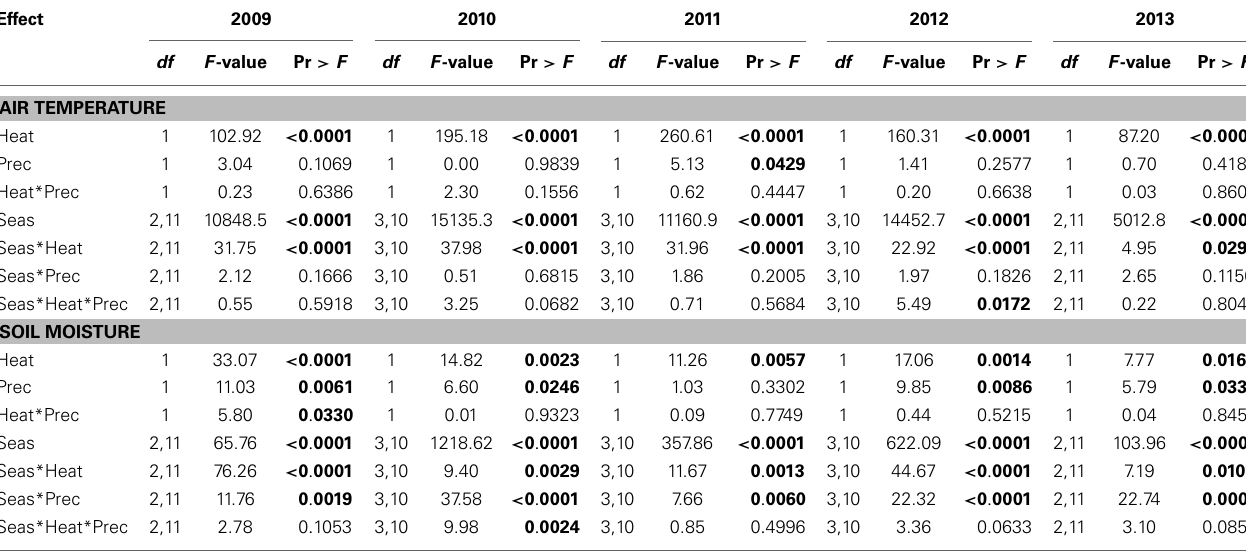
Table 1 | Statistical results of the effects of season, the climate treatments ( + heat and + precip), and their interactions on air temperature and soil moisture across the 5-years project period,